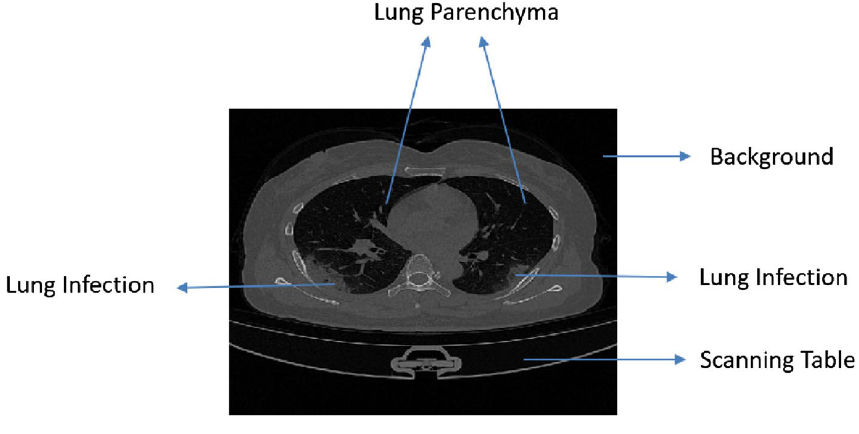
Figure 1. CT Image of